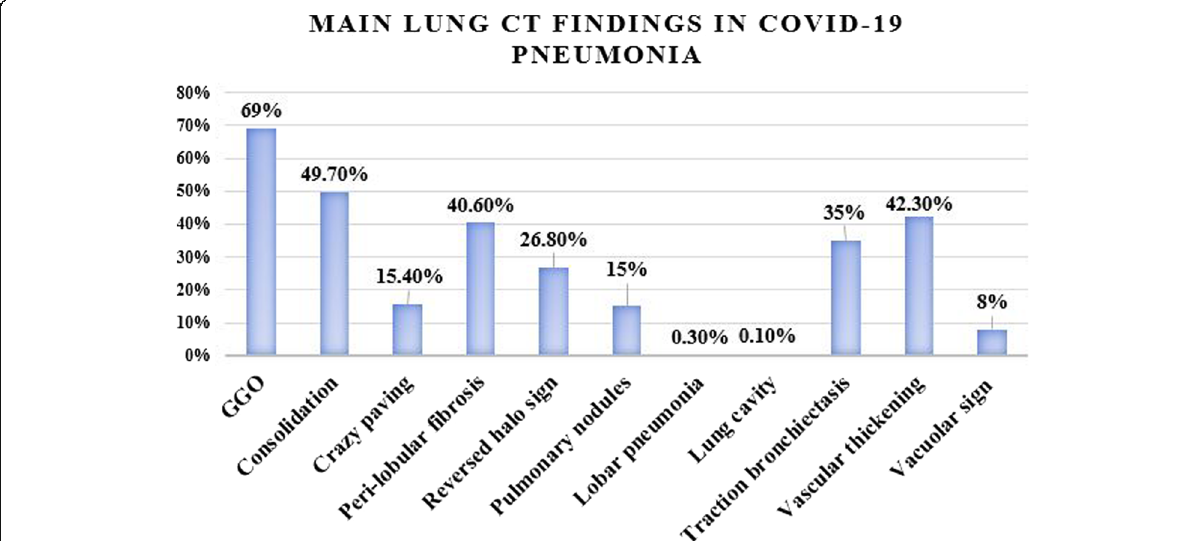
Fig. 2 Bar chart showing the prevalence of the main lung parenchymal CT findings in COVID-19 pneumonia